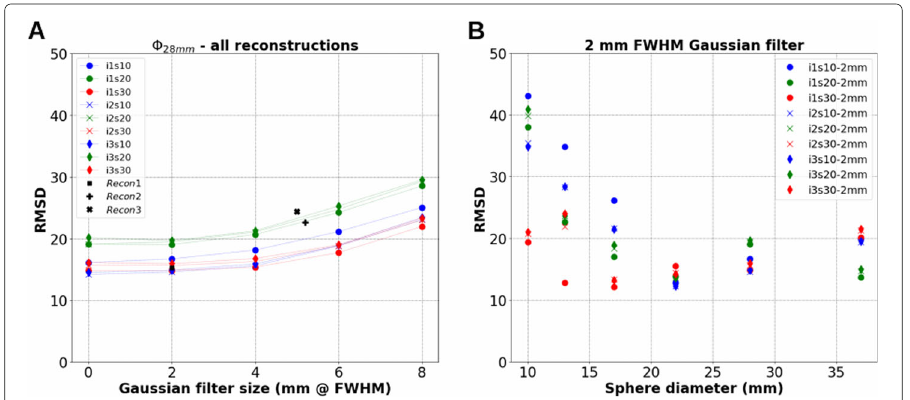
Fig. 4 RMSD between DVH VSV pet and DVH MC . A RMSD for all reconstructions for the 28-mm sphere against filter ref size. B RMSD against sphere sizes for reconstructions using a 2-mm FWHM post-reconstruction Gaussian filter only